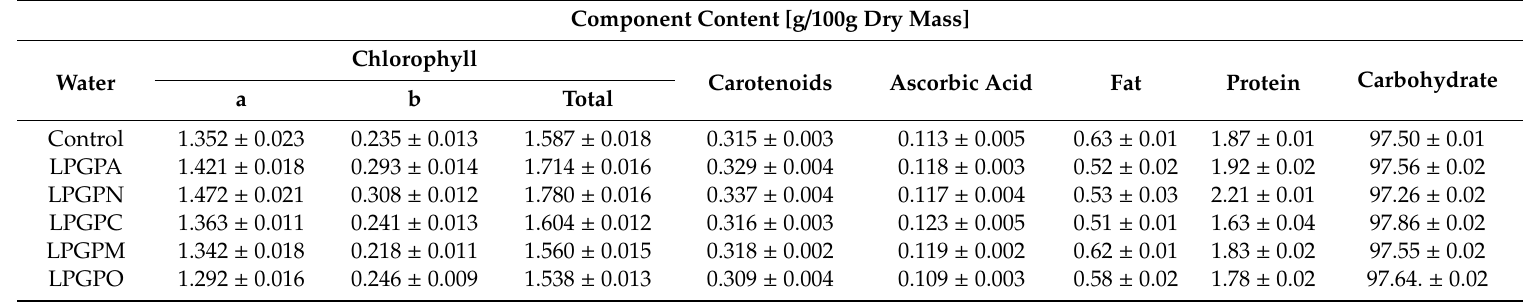
Table 2. Influence of watering plants with non-treated tap water and water treated with glow plasma in the air, (LPGPA) under nitrogen (LPGPN), carbon dioxide (LPGPC), methane (LPGPM) and molecular oxygen (LPGPO) on the yield of chlorophylls a and b, carotenoids and ascorbic acid.